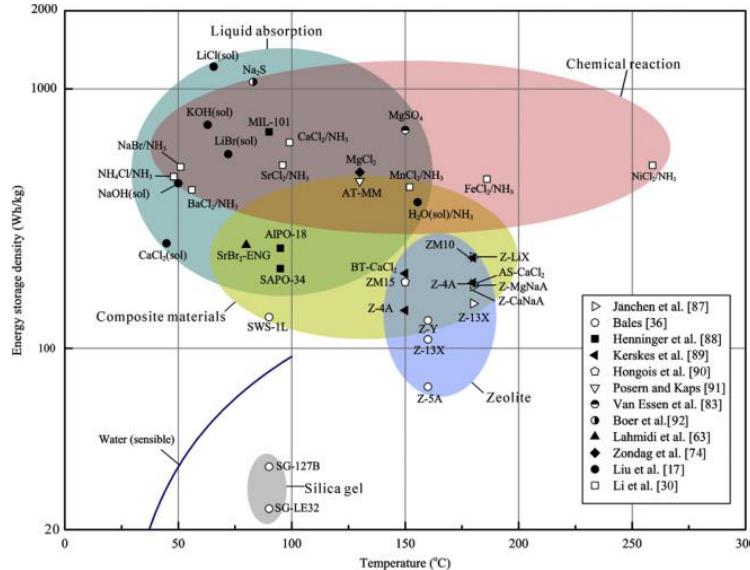
Figure 7. Illustrations showing energy density based on a single temperature [20].